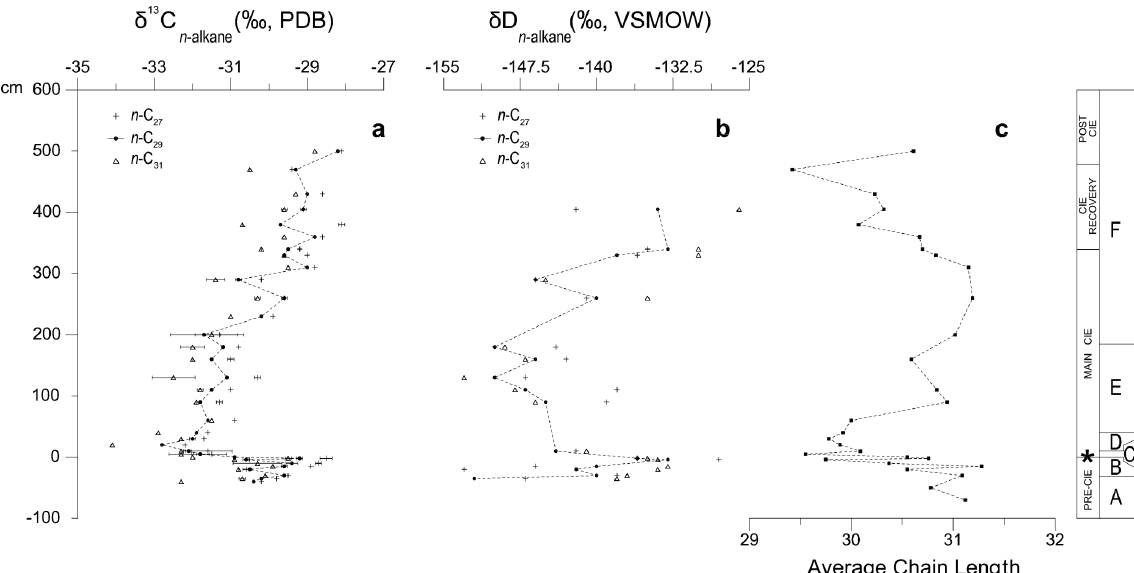
Figure 9. Stable carbon isotope ratios of higher plant n -alkanes (a) , stable hydrogen isotope ratios of higher plant n -alkanes (b) with higher plant average chain length values (c) for Forada PETM plotted against isotopic intervals and recognized benthic foraminiferal assemblages (A to F). Terrestrial higher plant n -C27, n -C29, and n -C31 δ D values are shown as crosses, closed circles, and triangles, respectively. Redrawn from data of Tipple et al.